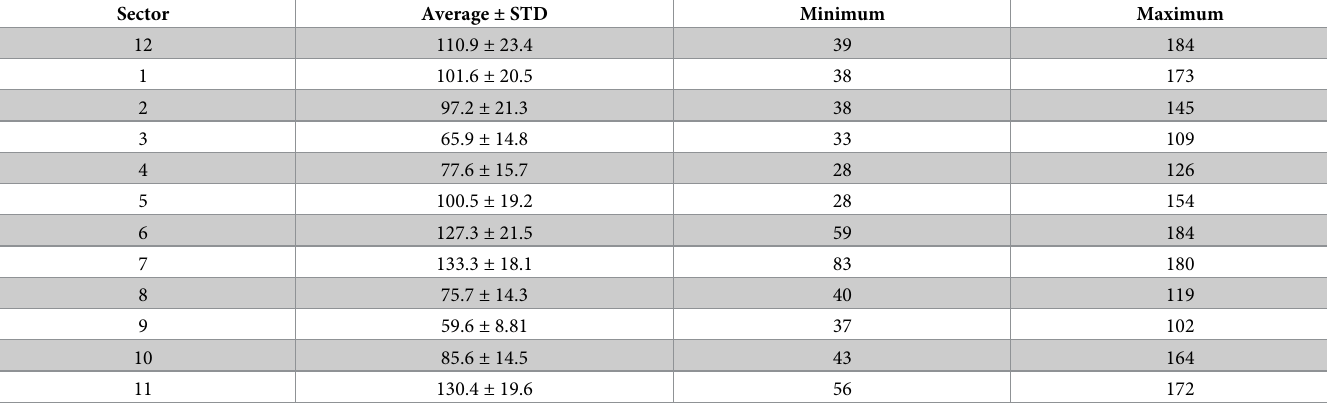
Table 2. Retinal nerve fibre layer thickness values for different sectors from horizontal optic disc scans.